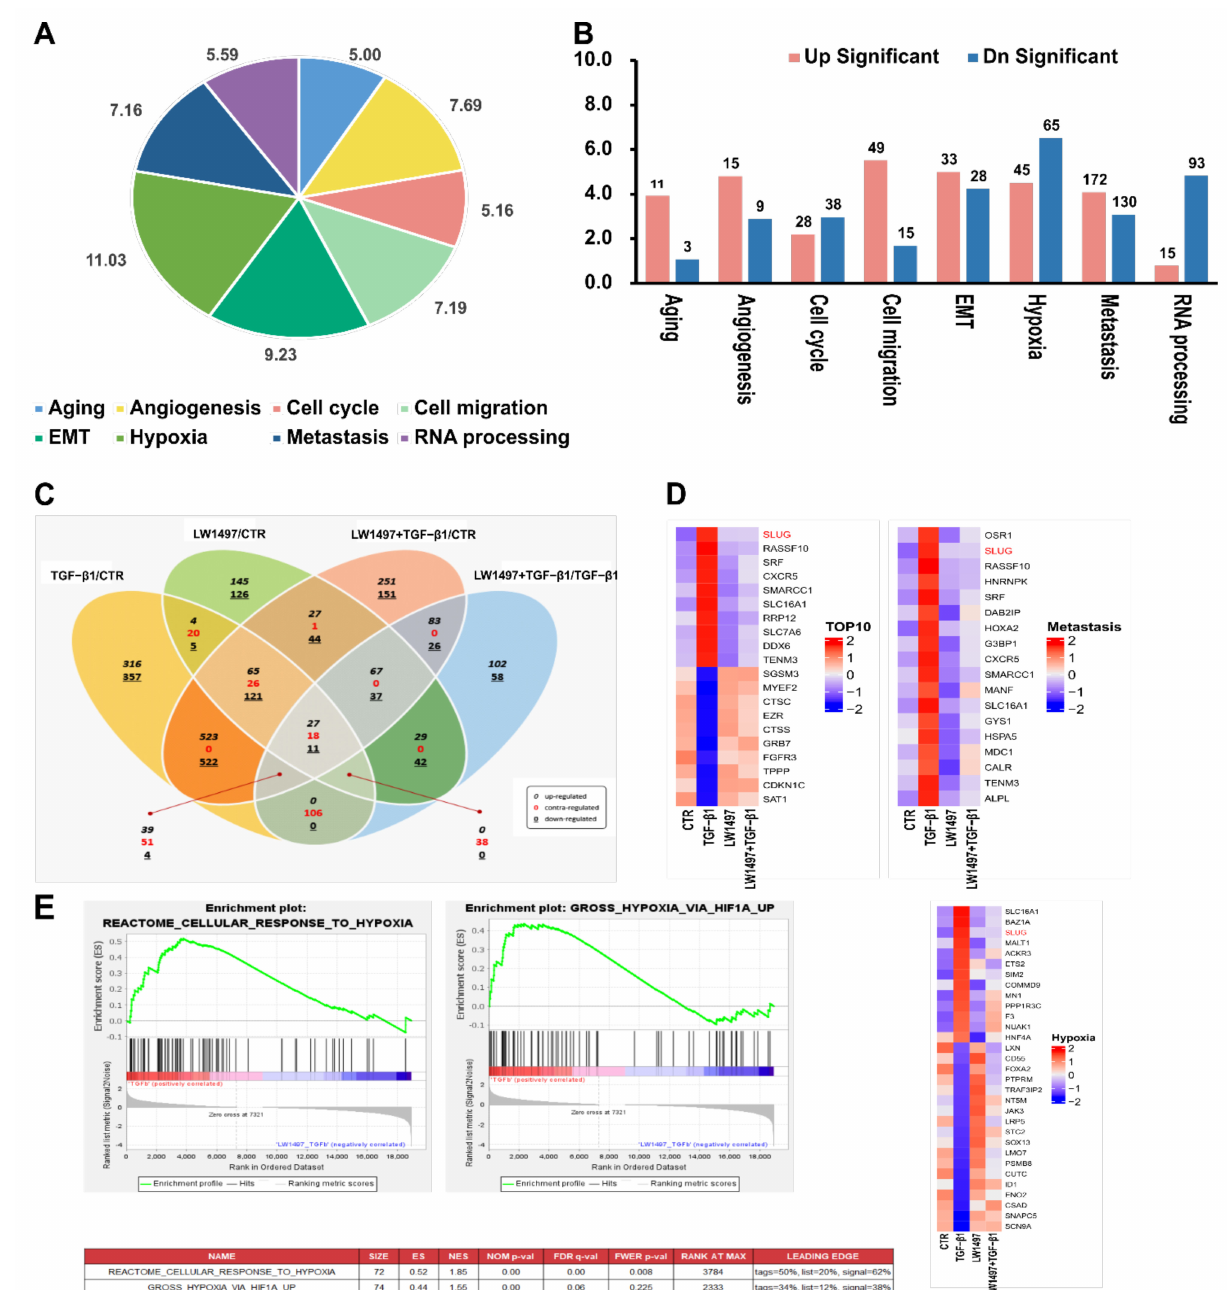
Figure 3. Transcriptome alteration analysis with RNA-seq in A549. ( A ) Distribution of the RNA-seq profiling annotated to the functional gene categories in LW1497 and TGF- β 1-treated A549 cells. ( B ) List of enriched Gene Ontology term biological process for LW1497 and TGF- β 1-treated group. Upregulated (pink) and downregulated (blue) genes were quantified. ( C ) Venn diagram of gene annotations comparisons between TGF- β 1, LW1497, TGF- β 1 with LW1497 and CTR. Venn diagram showing the overlap of differentially expressed genes (DEGs) specifying upregulated (black, italics), contra-regulated or genes that have diverse regulation polarity (red), and downregulated (black, underlined) genes in four pair-wise comparisons. The Venn diagram was generated using ExDEGA from E-biogen. ( D ) Heatmaps of representative top 10 up and downregulated genes, metastasis, hypoxia, and Hif1a-related genes from A549 RNA-seq results. ( E ) GSEA revealed positive enrichment of gross hypoxia via HIF1 α -up and reactome cellular response to